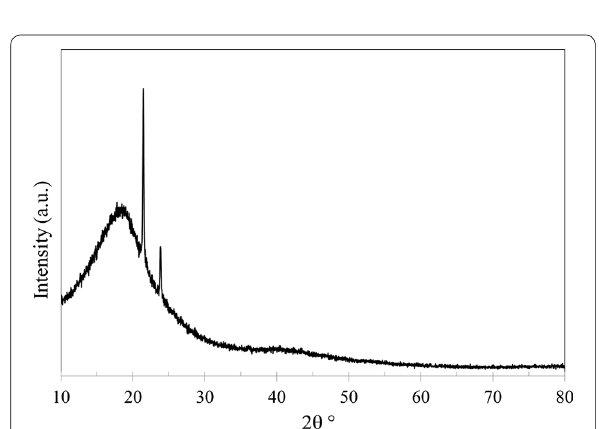
Fig. 8 Cross‑section image of GBL membrane made by 27 wt% PEI